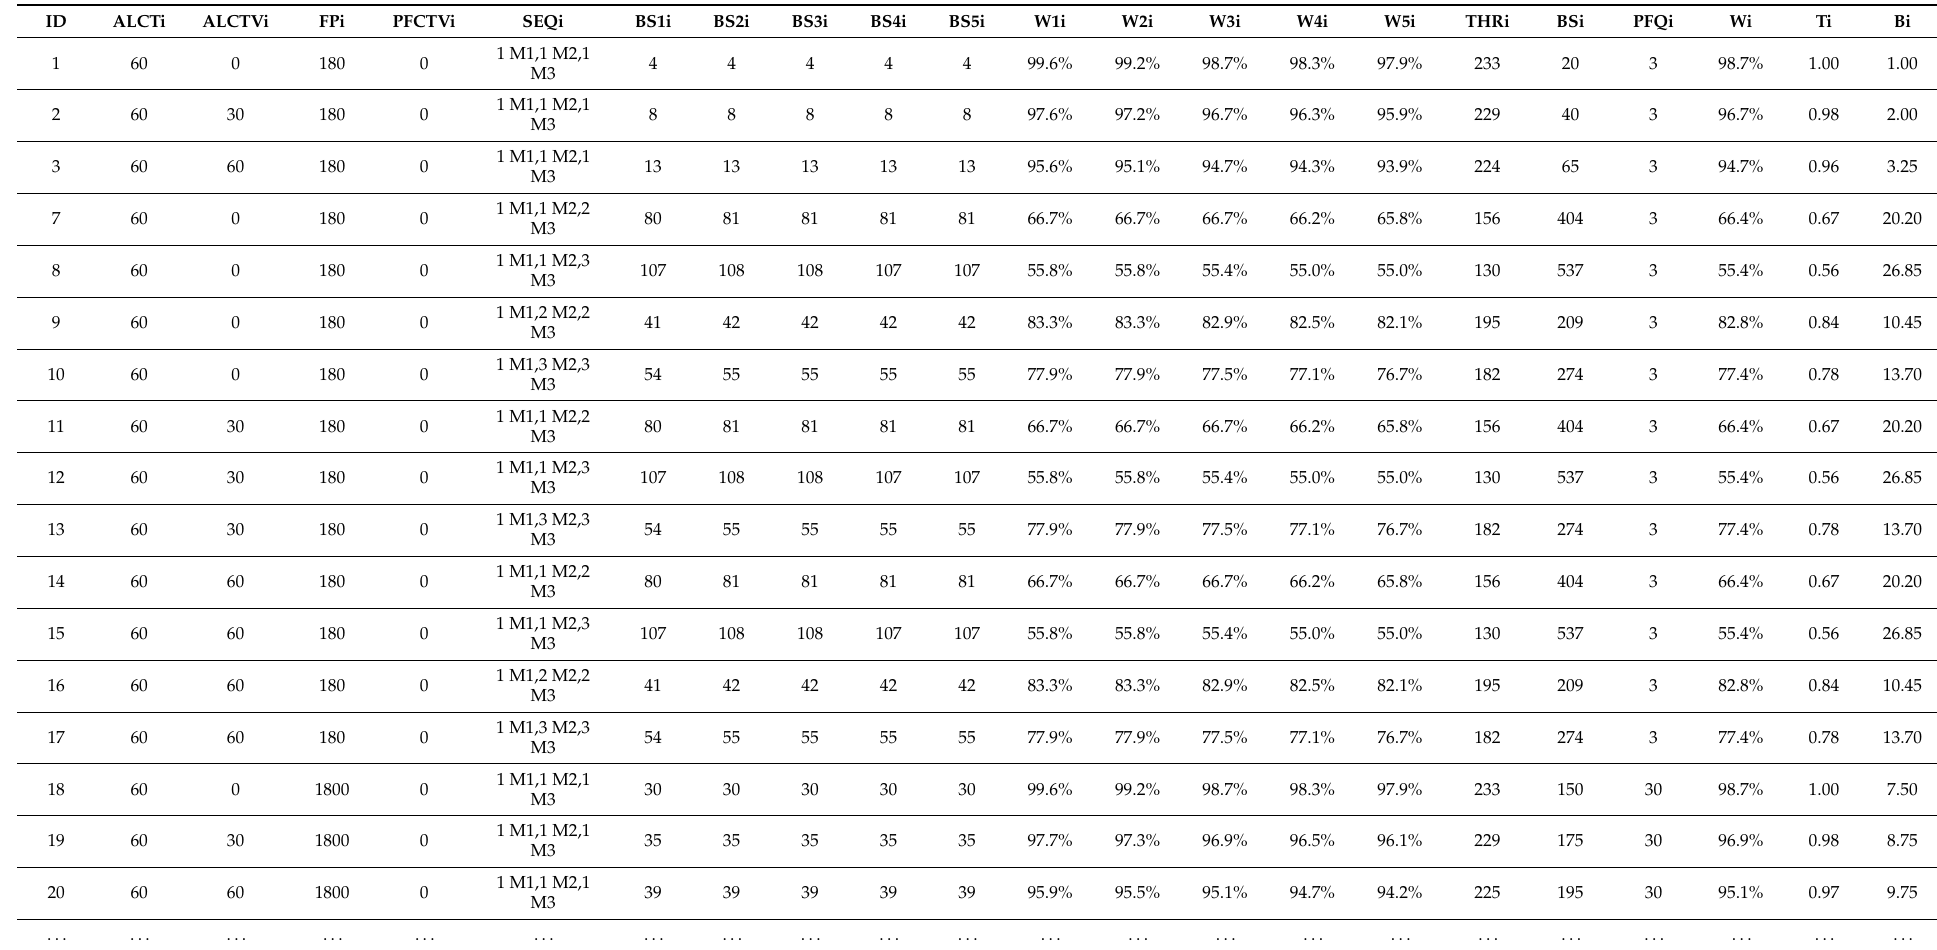
Table 3. Example of the simulation inputs and outputs for each tested scenario. The first column represents the scenario index, columns 2 to 6 collect the different values of the input parameters, and the remaining columns list the simulation